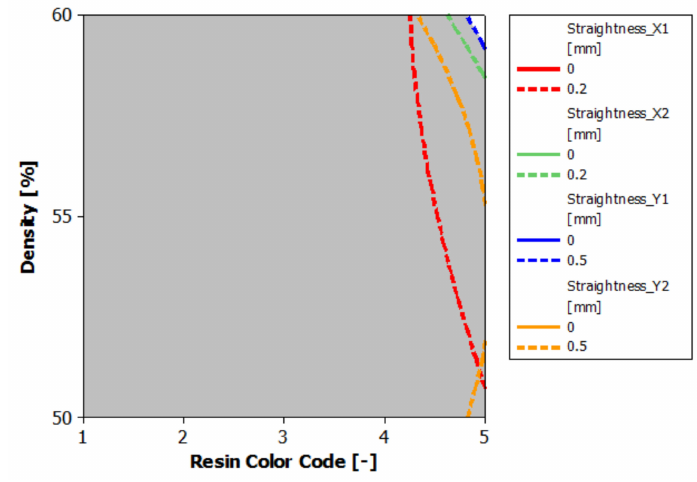
Figure 25. Overlaid contour plot of Straightness_X1; X2; Y1; Y2. The fourth conclusion involves determining optimal conditions that will produce the best value for the printed part body shape deviations. Since flatness and straightness of properties will be considered simultaneously. Figure 26 shows an optimal solution for the input variables.